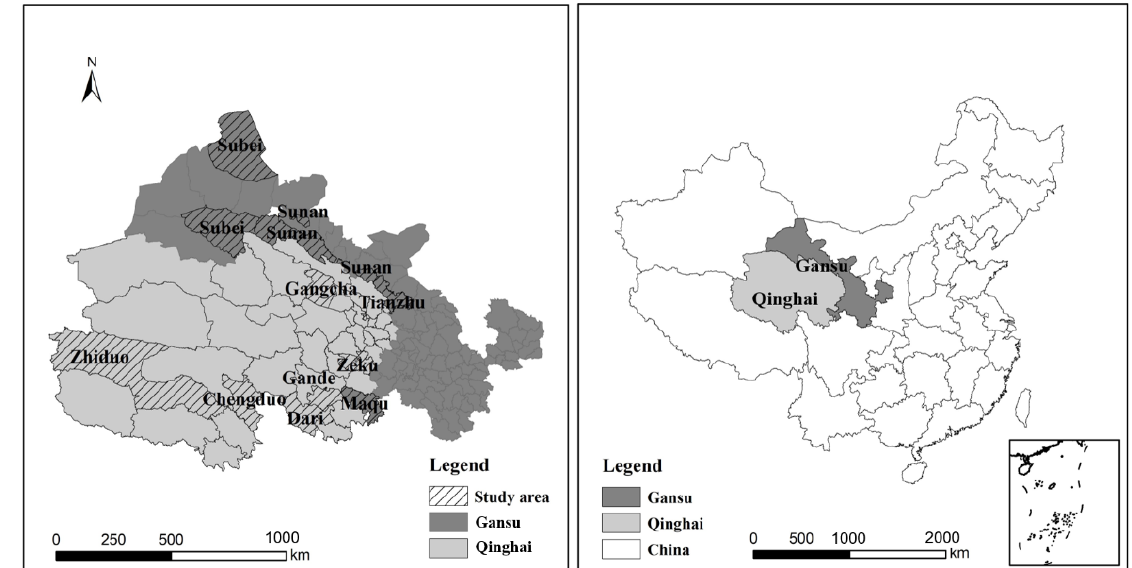
Figure 1. Locations of sampled counties.